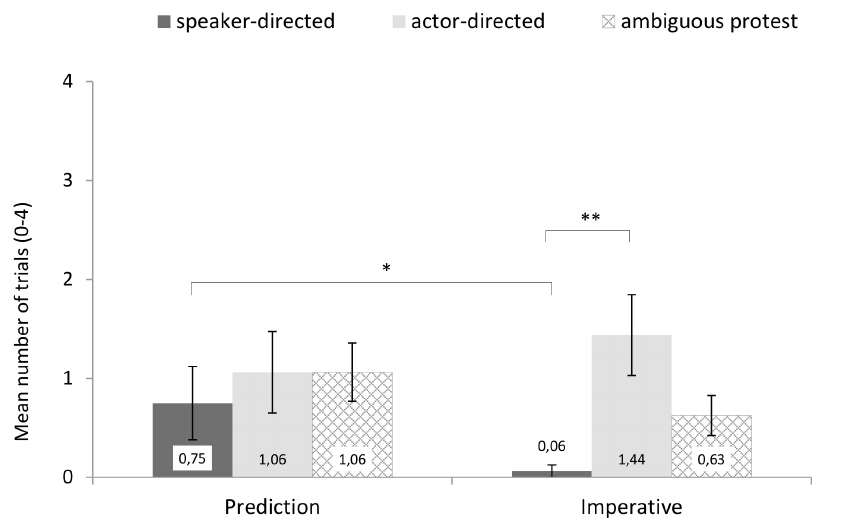
Figure 2. Responses to mismatches in Study 1 (verbal protest measure). ean scores of trials (0–4) per condition (Prediction, Imperative) with each kind of protest (speaker-directed, actor-directed, ambiguous).